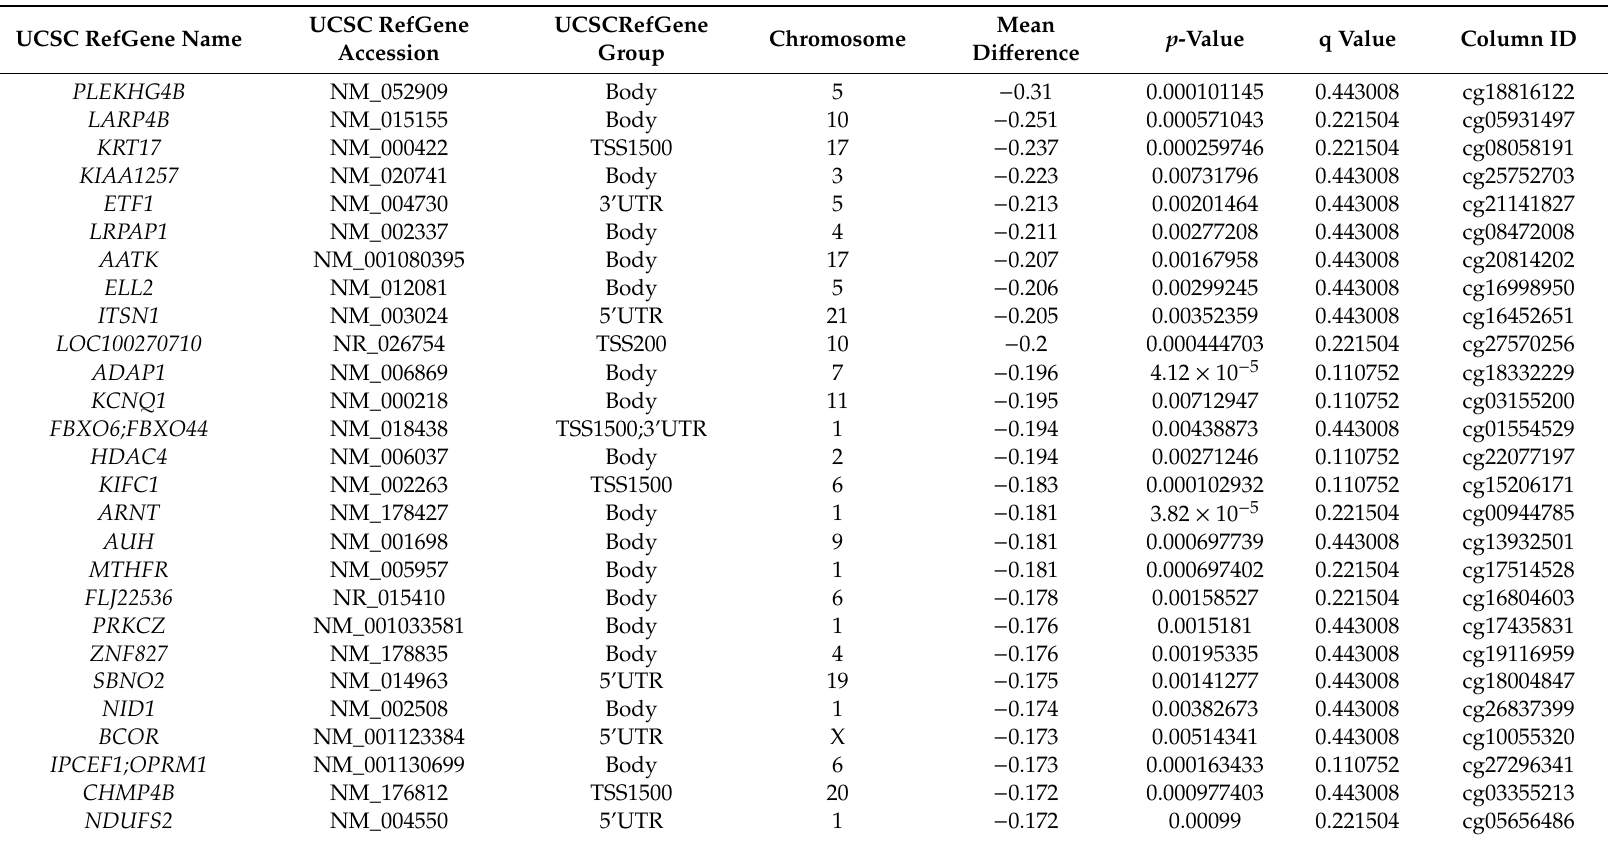
Table 2. Top di ff erentially methylated loci (DMLs) in the comparison between active TB patients and healthy subjects (comparison